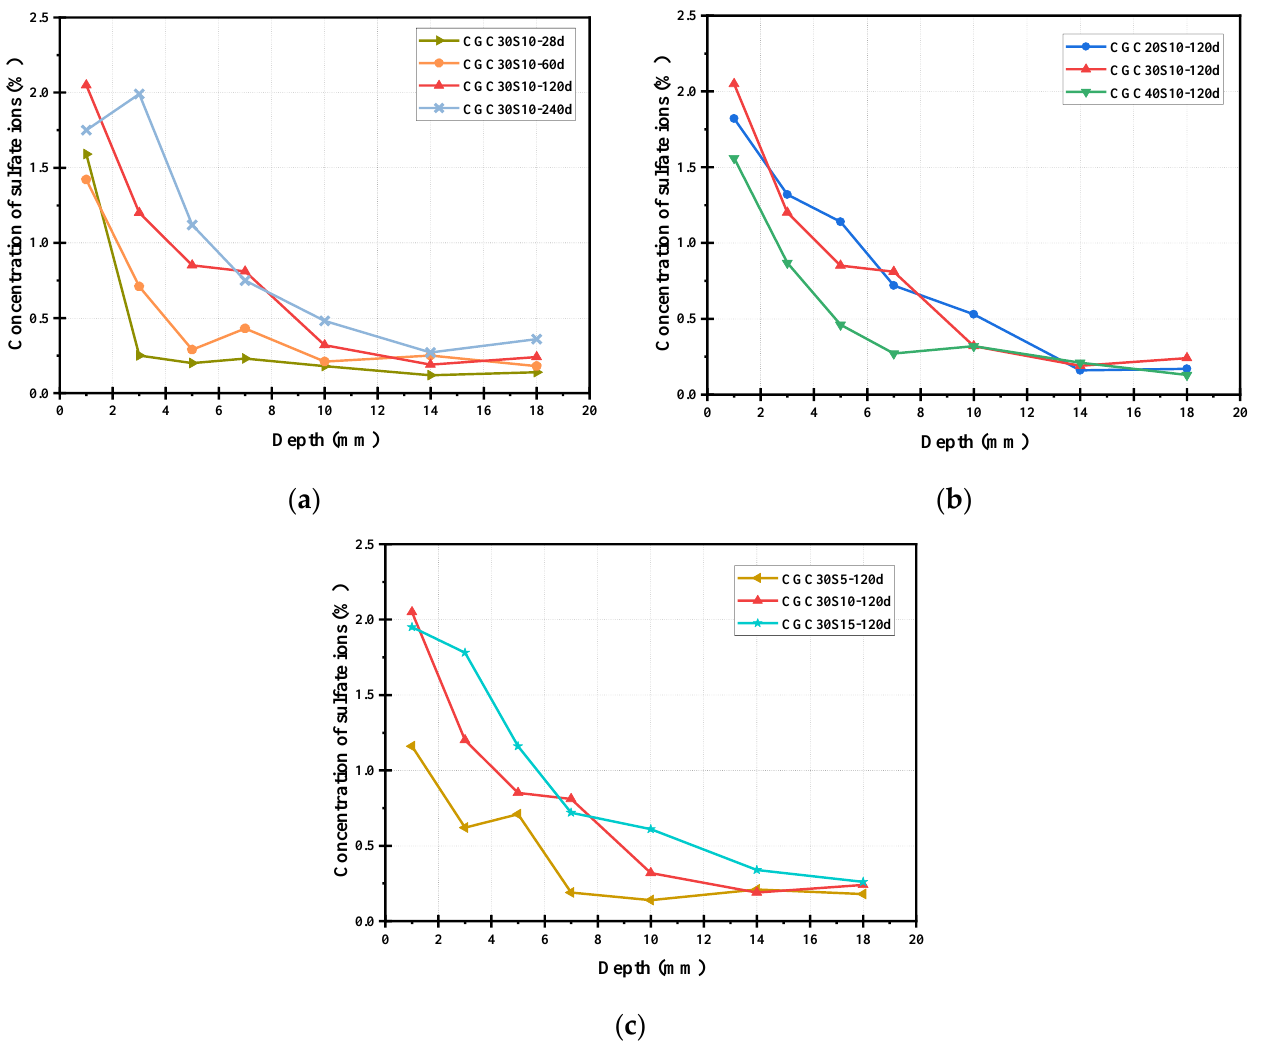
Figure 8. Distribution of sulfate ions in different sulfate-attacked concrete: ( a ) corrosion time; ( b ) CGC strength; ( c ) sulfate concentration.